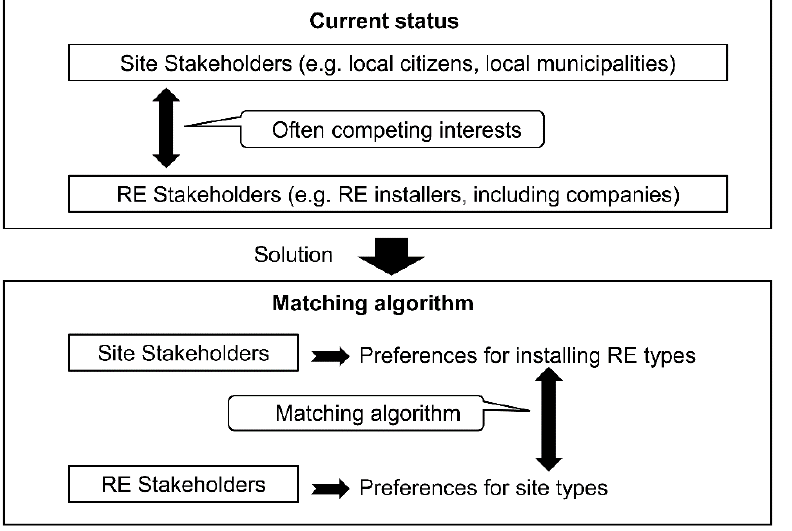
Figure 1. Applying the matching algorithm to match sites and renewable energy (RE).